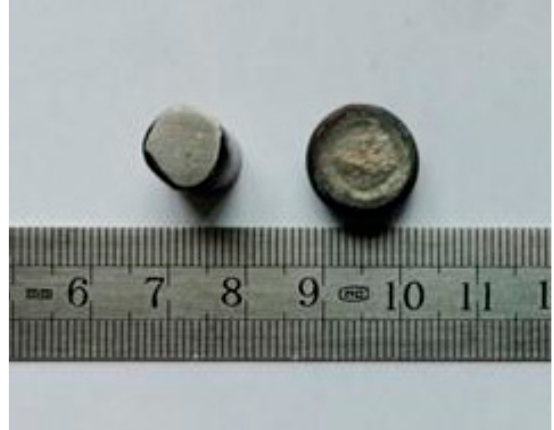
Figure 5. Samples after canning and isothermal compression.